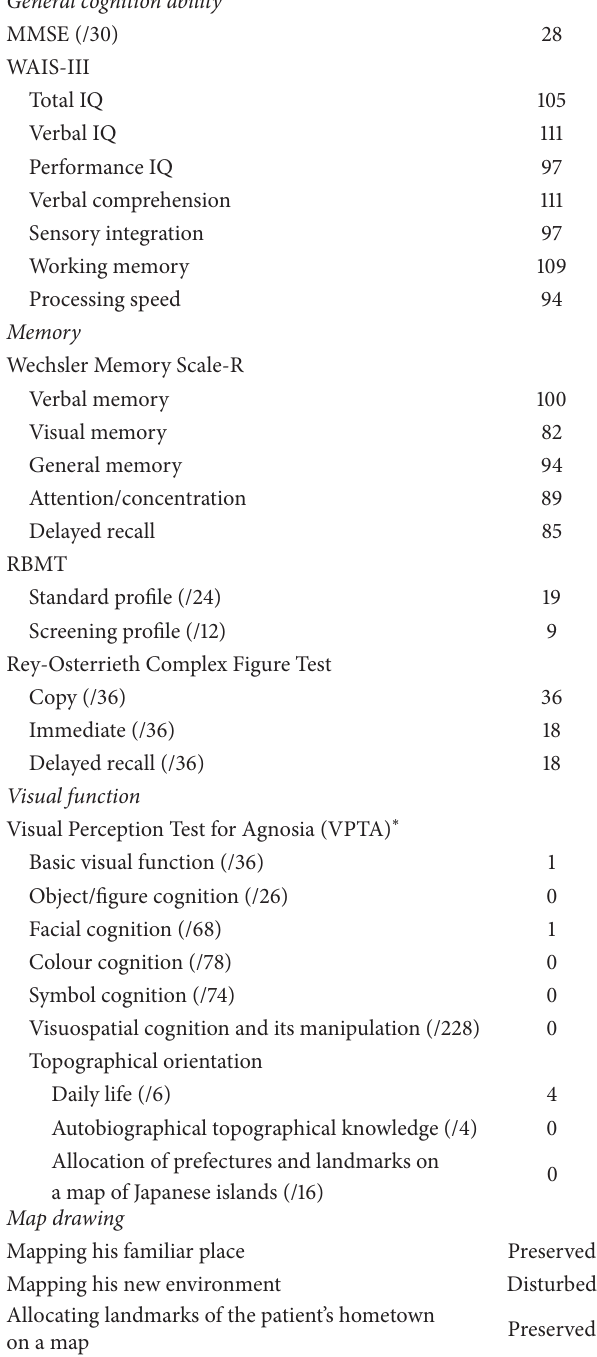
Table 1: Neuropsychological test results in the present